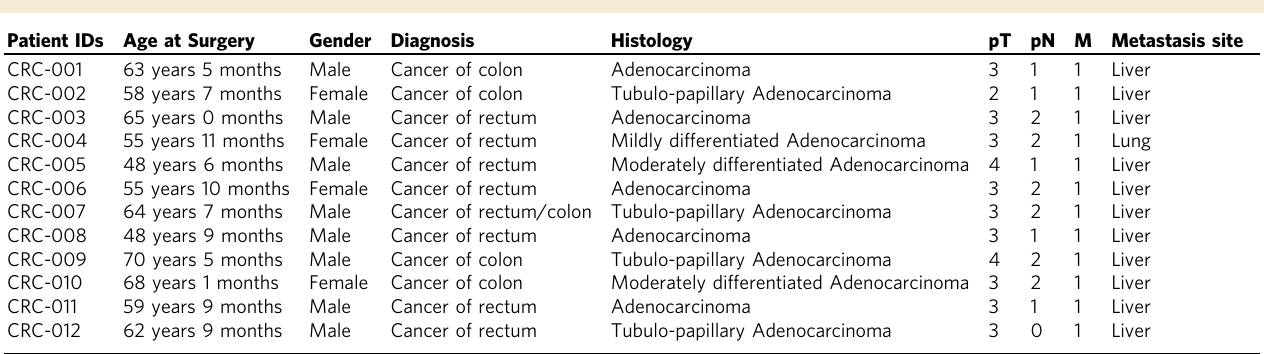
Table displaying the anonymized/pseudonymized patient ID, age, gender, diagnosis and histology of patients/tumors. Theinitial staging of the disease is shown in fi elds for primary tumor (pT), regional lymph nodes (pN), distant metastasis (M)